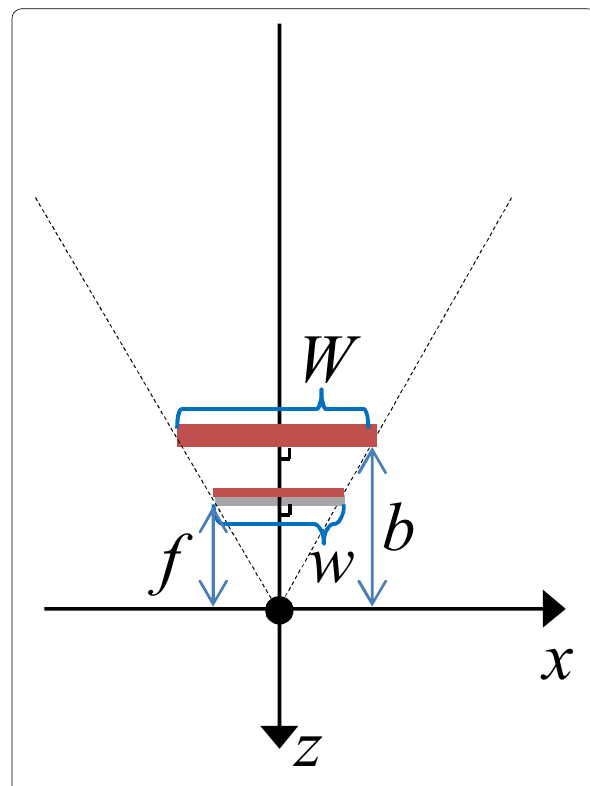
Fig. 7 Diagram of base distance b on the perspective camera